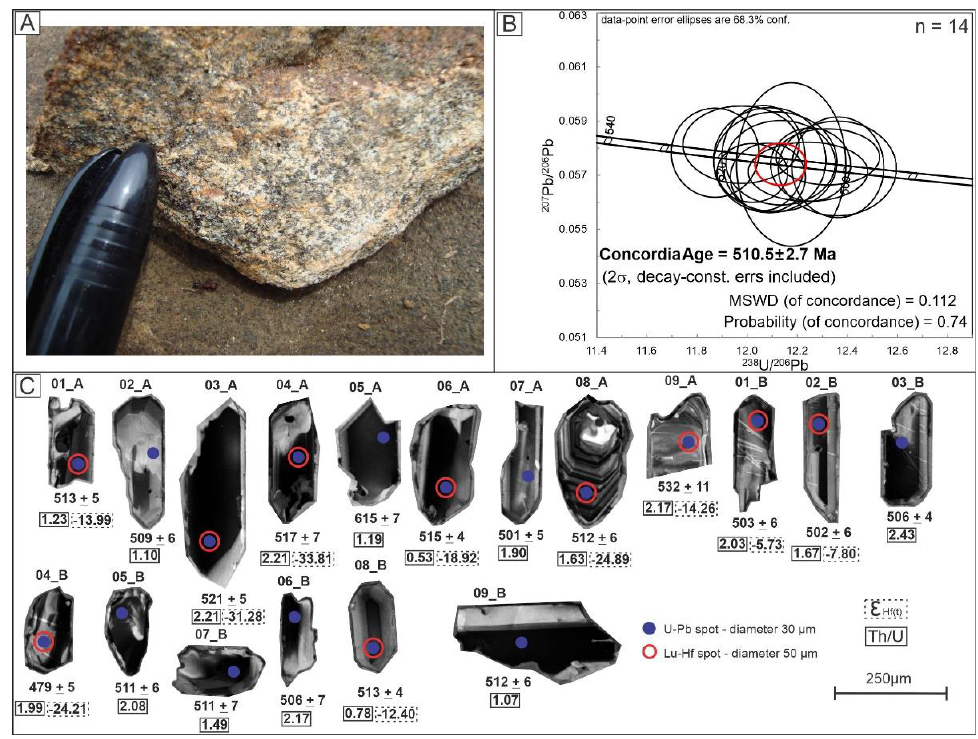
Figure 10. ( A ) A representative sample of SAIC felsic hybrid rock from the point SAIC-10. ( B ) Con- cord age for the sample SAIC-10B. ( C ) Cathodoluminescence image of the analyzed zircon grains.